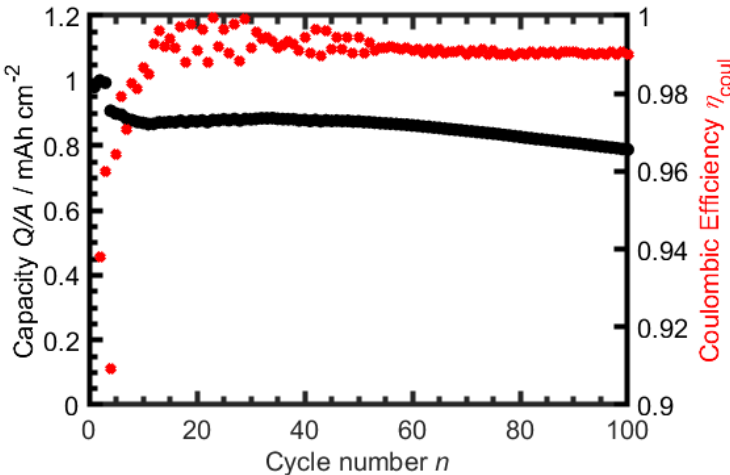
Figure 5. Cycling performance of a graphite/NCM cell with 1 M LiFSI in TBAC:EC:EMC (80:15:5 wt) electrolyte at T = 25 ◦ C. The cell was charged and discharged at C−rate C